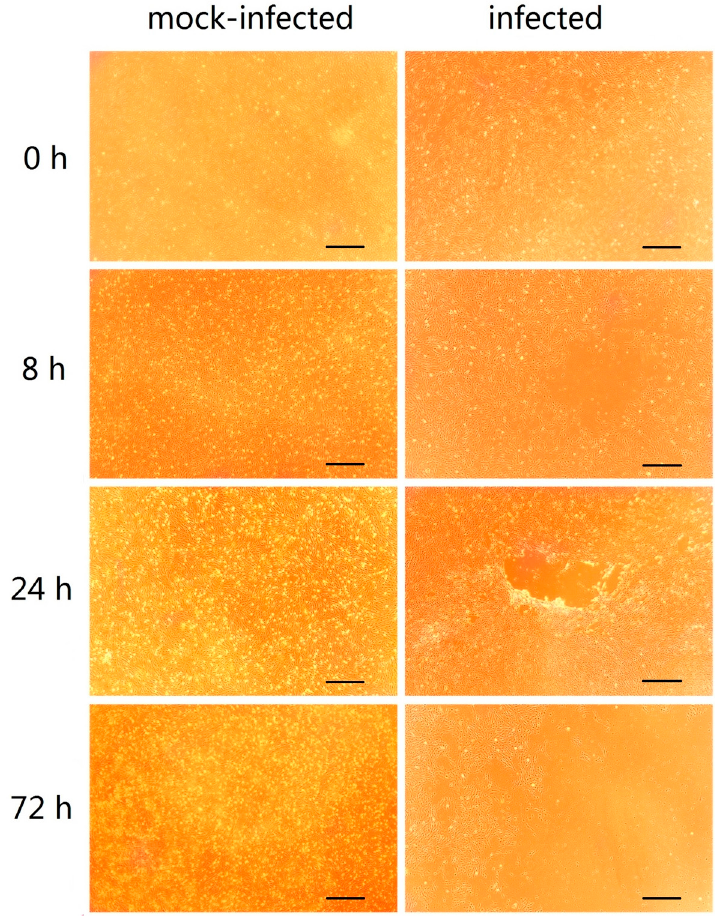
Figure 1. ( C. idellus kidney) CIK cells mock-infected and infected with grass carp reovirus (GCRV). The images were adjusted for contrast to improve their appearance, scale bar represents 200 μ m.